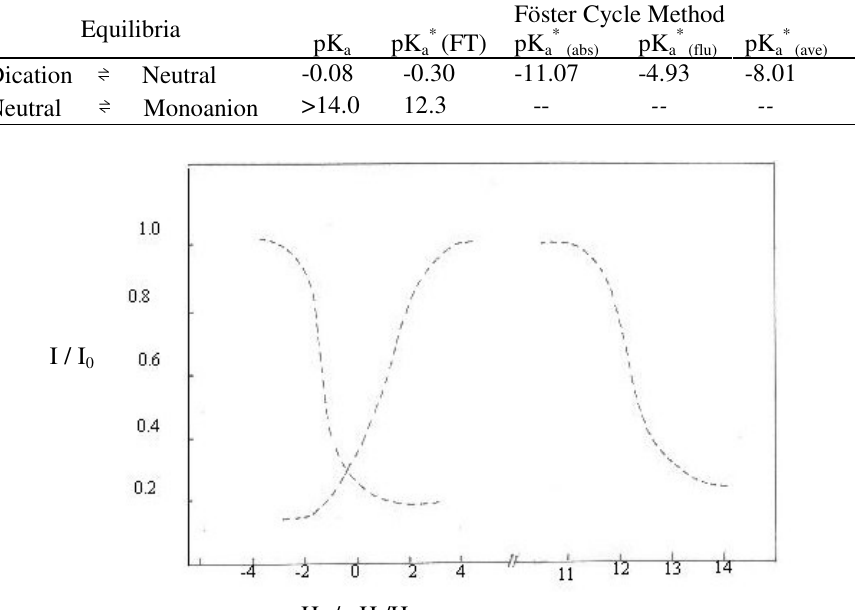
Table 4 . pK a values of various prototropic equilibria of DAAQ in the lowest excited singlet and ground states.